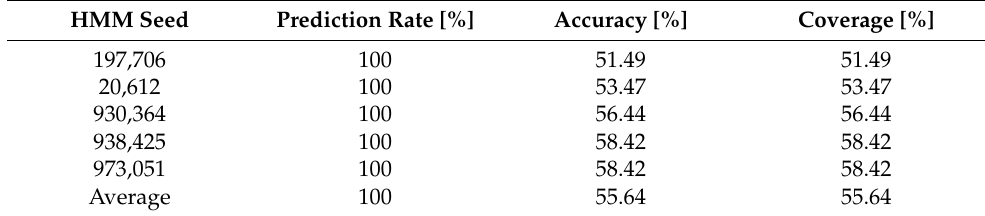
Table 2. The accuracy of each seed for 30 hidden states on the students’ dataset.